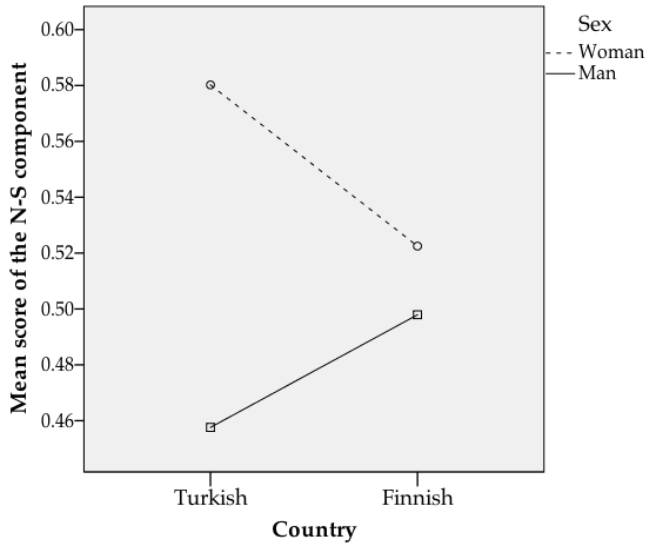
Figure 2. Interaction effect of sex and nationality on N-S mean scores.